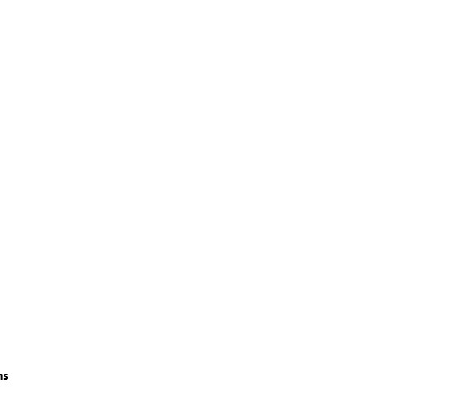
Figure 3. PSNRs (dB) of DIP evaluated on the Barbara, Cameraman, and Peppers images with the noise level σ = 50.